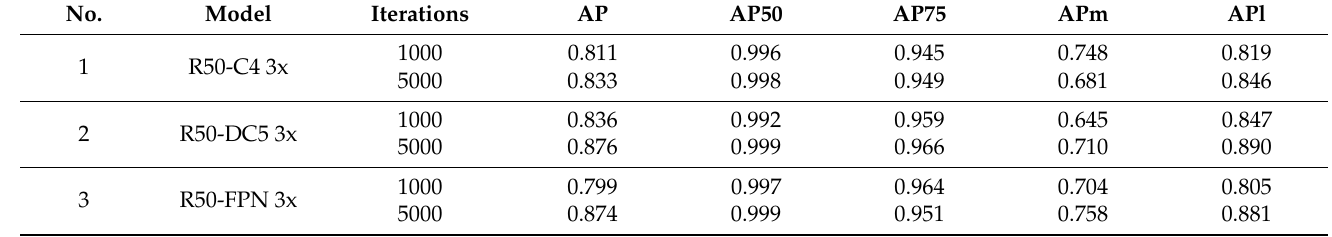
Table 2. Comparison of Various Models and Repeated Test Results (Bounding Box).